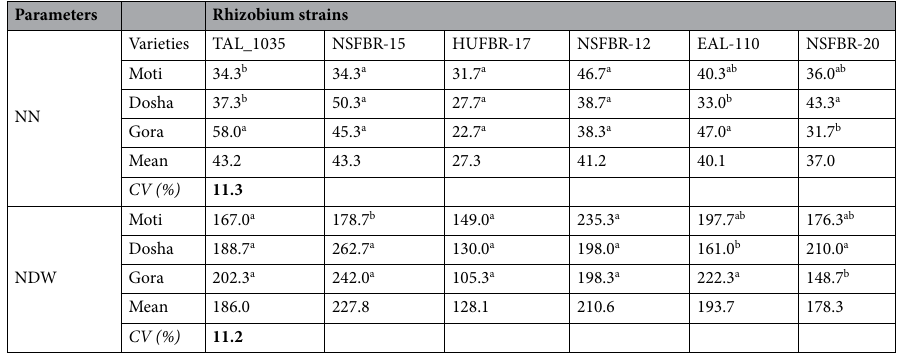
Table 3. Rhizobium strain x faba bean variety interaction effects on nodule numbers (NN) and nodule dry weight (NDW) per plant under greenhouse condition. Mean values in the same column with different letter(s) are significantly different at p ≤ 0.05 probability